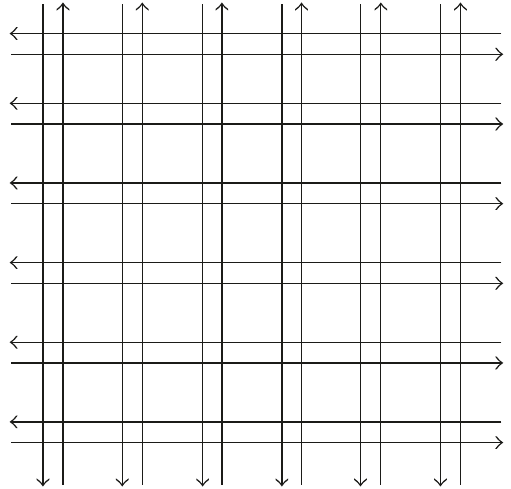
Figure 5: Example of node movement in the Manhattan model.